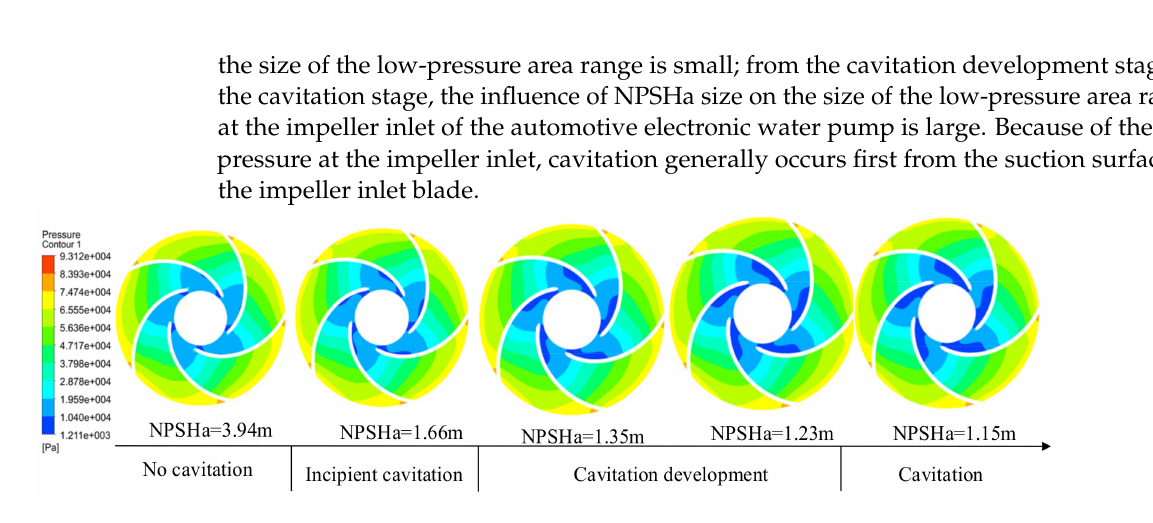
Figure 11. Pressure distribution of bubble formation process.